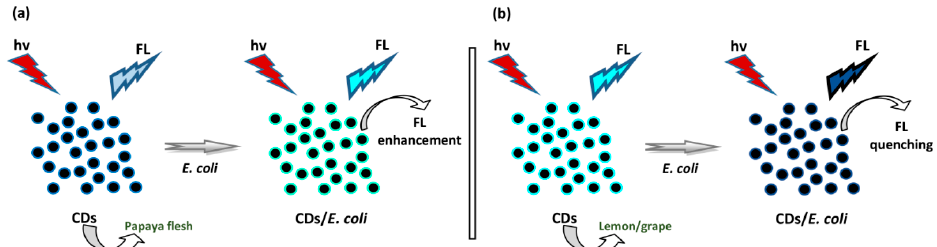
Figure 9. Schematic illustration of plant part-derived CDs for the sensing of E. coli with ( a ) FL